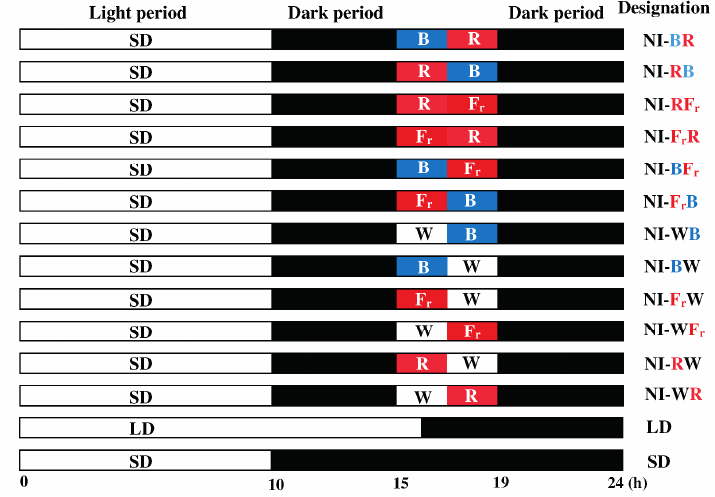
Figure 4. Representative image of the shifts in the light quality of night interruption (NI) by light emitting diodes (LEDs) during 4 h night interruptions (NI) of the 10 h short-day (SD) treatments in Dendranthema grandiflorum “Gaya Yellow”: NI-BR, blue to red; NI-RB, red to blue; NI-RFr, red to far-red; NI-FrR, far-red to red; NI-BFr, blue to far-red; NI-FrB, far-red to blue; NI-WB, white to blue; NI-BW, blue to white; NI-FrW, far-red to white; NI-WFr, white to far-red; NI-RW, red to white; and NI-WR, white to red. The LD indicates the 16 h long day treatment.